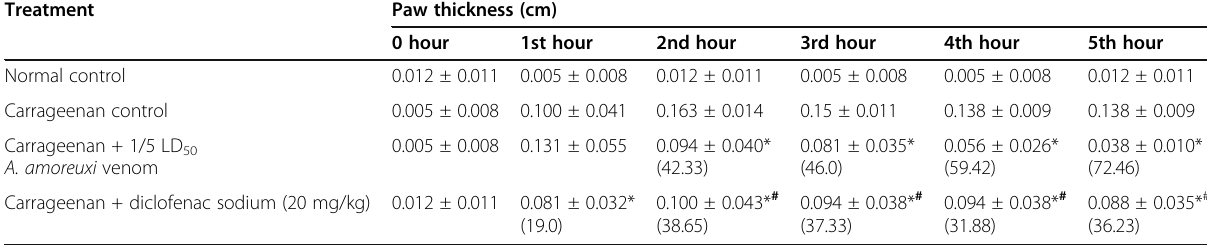
Table 3 Antiinflammatory effect of A. amoreuxi venom using carrageenan-induced paw edema in mice Treatment